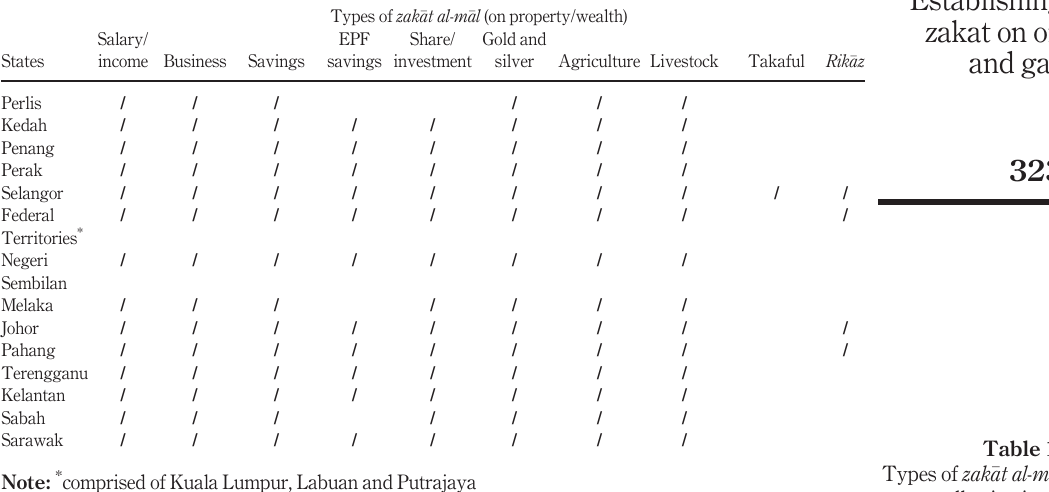
Table 1. Types of zak (cid:1) at al-m (cid:1) al collection in